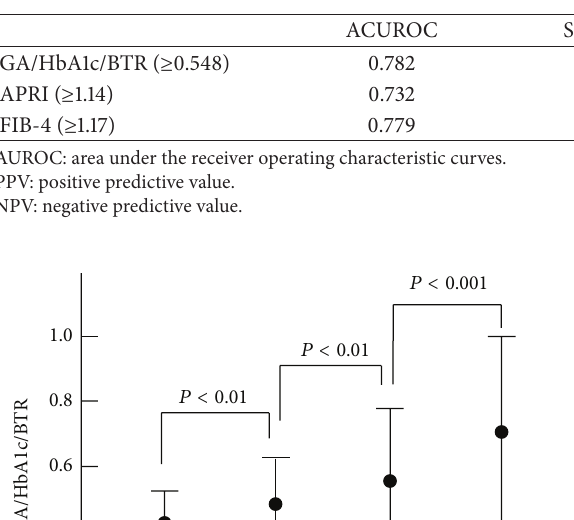
the three markers (GA/HbA1c/BTR, FIB-4, and APRI) for